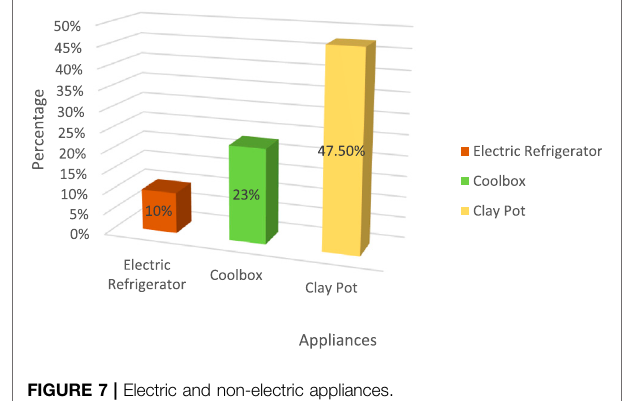
FIGURE 7 | Electric and non-electric appliances.